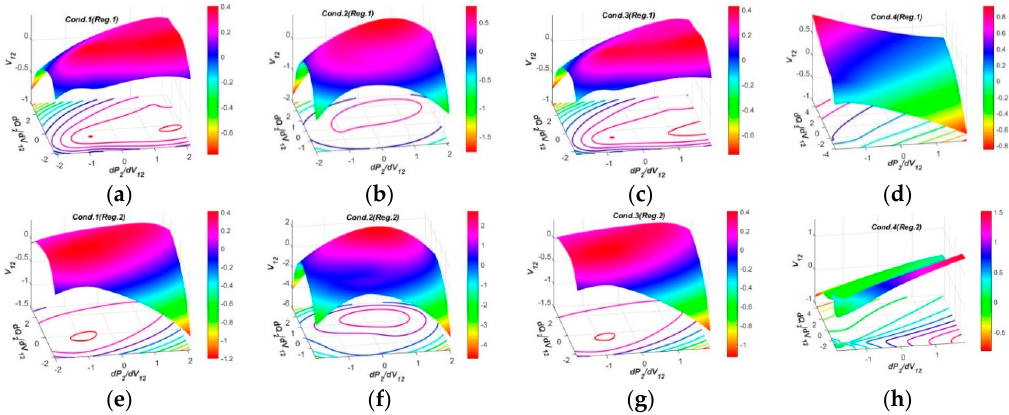
Figure 8. Spatial surfaces of PFG to CIV1 at SCP3 in spaces: ( a – d ) Spatial surfaces of PFG to CIV1 by Reg.1 mode of OSIV in four operation conditions; ( e – h ) Spatial surfaces of PFG to CIV1 by Reg.2 mode of OSIV in four operation conditions.